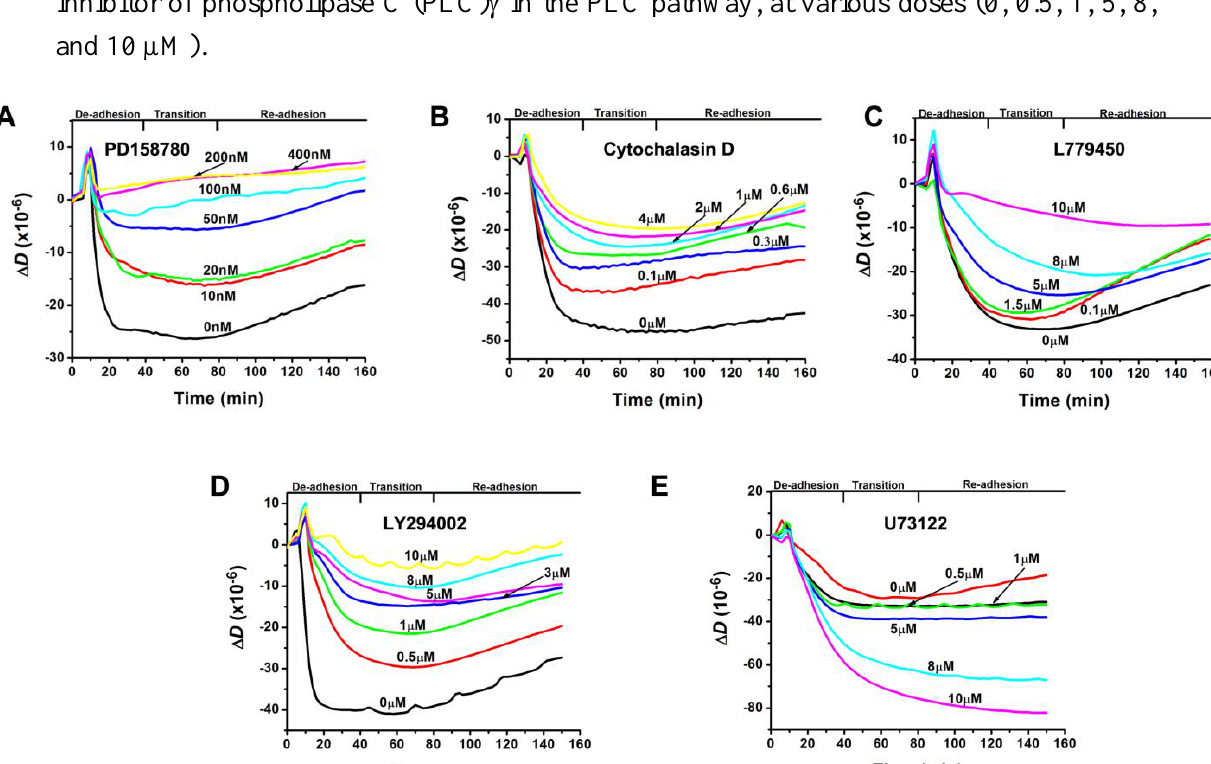
Figure 1. Real-time quartz crystal microbalance with dissipation monitoring